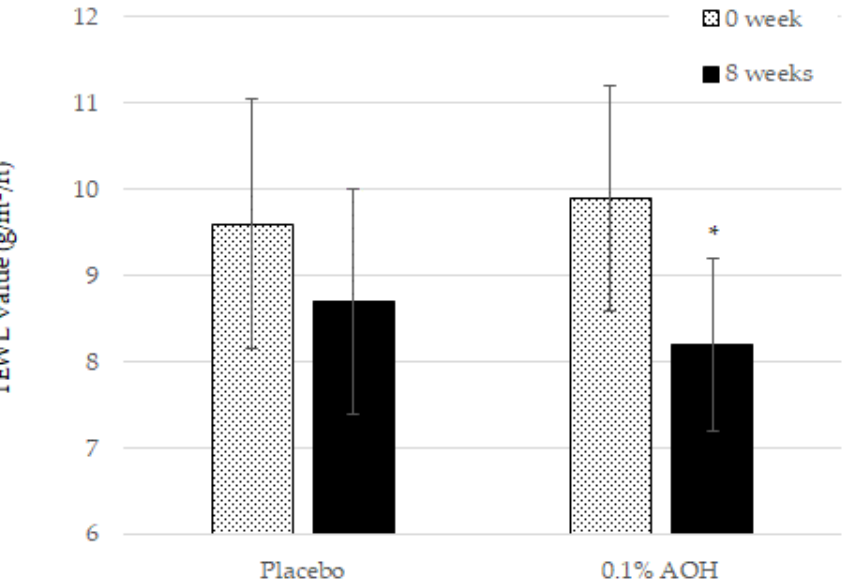
Figure 3. Trans-epidermal water loss (TEWL) value at the beginning of the study and after 8 weeks; * p < 0.05 vs. 0